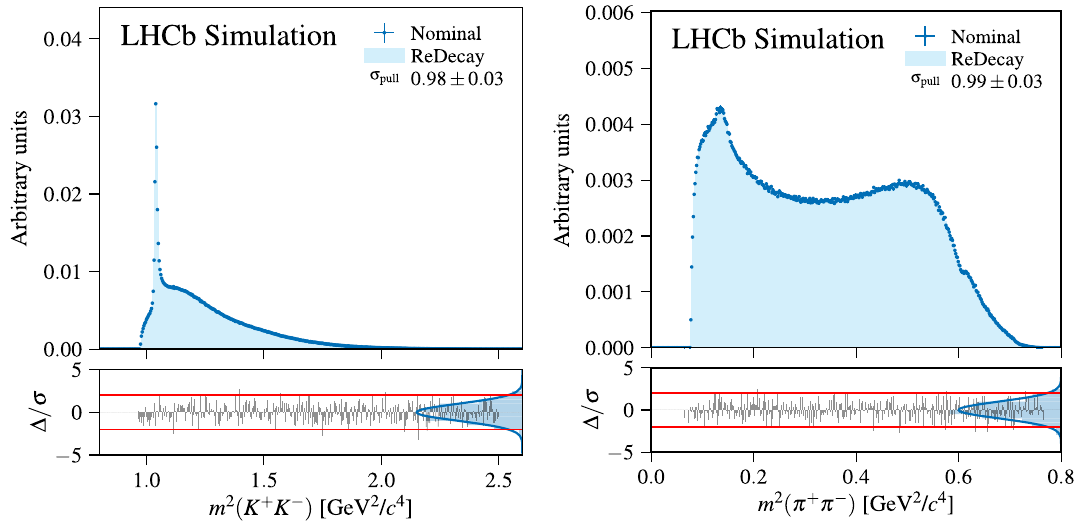
Fig. 2 Comparison of a ReDecay sample with a nominally produced sample of D 0 → K − K + π + π − decays. Shown are the invariant mass squared of the kaon pair (left) and pion pair (right) which are both inde-